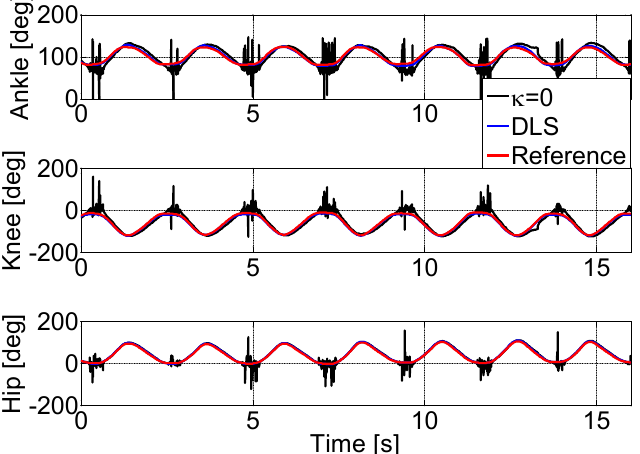
Figure 4. The joint angles obtained from both ultrasonic and optical tracking system during a 15-s consecutive planar squat exercise. The black line makes use of the pseudo-inverse method, that is κ = 0 . The blue line is the damping least-squares method. The red line is a reference result.